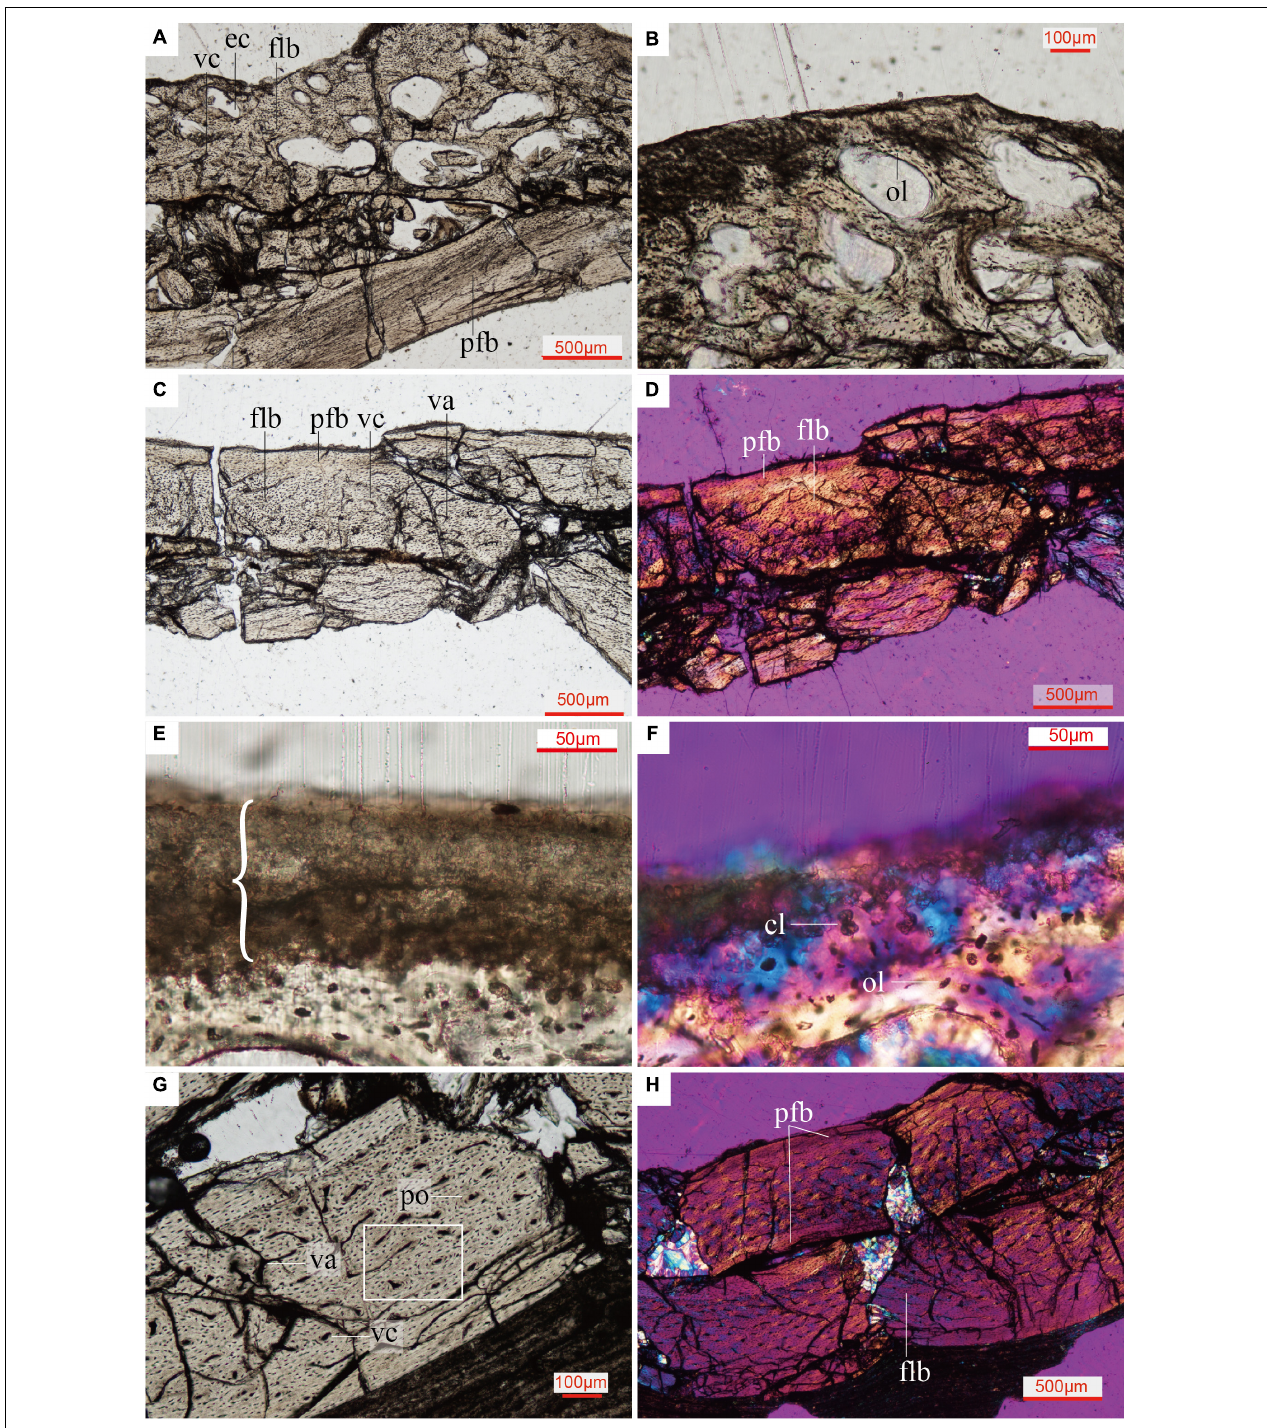
FIGURE 4 | Close up histology (ground-section) of Confuciusornis IVPP V11521. (A) Osteohistology beneath the glenoid fossa, showing that the cancellous bone consists of fibrolamellar tissue and the compact bone consists of parallel-fibered tissue; (B) Osteohistology around the trabeculae and erosion cavities; (C) osteohistology of the scapula blade; (D) osteohistology of the scapular blade under polarized light; (E) brace indicates dark layer without celluar structures, comprising diagenetically altered calcified cartilage, with potential remnants of hyaline cartilage mixed with sediment, location of the section is indicated in Supplementary Figure 2B ; (F) highly diagenetically altered calcified cartilage under polarized light; (G) osteohistology of the humerus; (H) osteohistology of the humerus under polarized light. cl, chondrocyte lacunae showing a cell-doublet organization; cn, cancellous bone; cr, coracoid; ec, erosion cavity; flb, fibrolamellar bone; gf, glenoid fossa; ol, osteocyte lacunae; pfb, parallel-fibered bone; po, primary osteon; sc, scapula; vc, vascular canals; va, vascular canals anastomose.